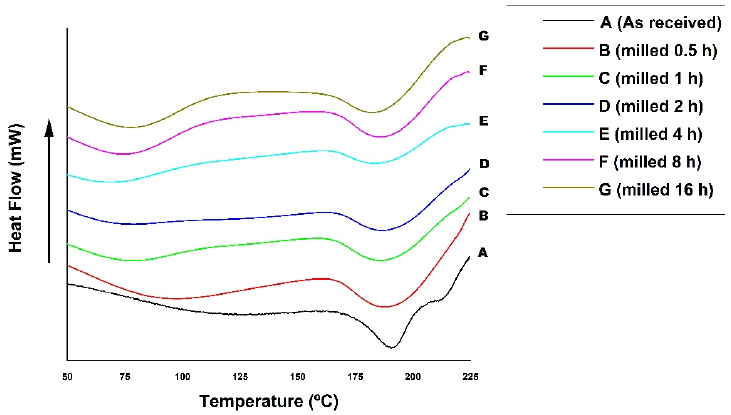
Figure 5. Differential Exploratory Calorimetry Curve (DSC). PVA in several milling conditions com- pared to the as–received material.